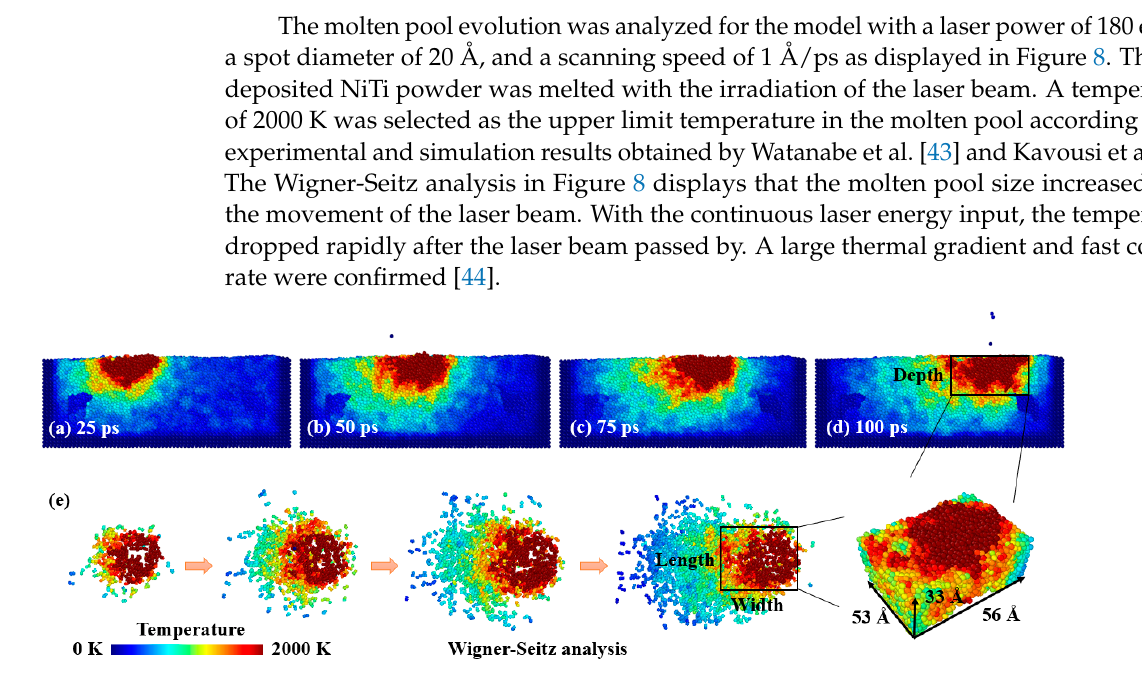
Figure 8. The molten pool evolution and the Wigner-Seitz analysis [45] during L-PBF with a laser power of 180 ev/ps, a spot diameter of 20 Å, and a scanning speed of 1 Å/ps: ( a – d ) are the cross-section view at time of 25 ps, 50 ps, 75 ps, and 100 ps, respectively; ( e ) molten pool morphology evolution.